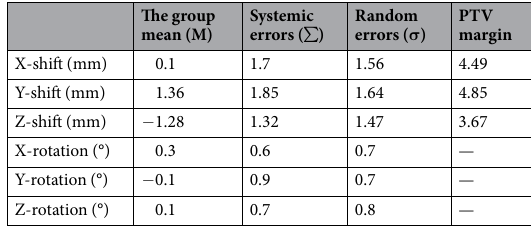
Systemic errors ( ∑ )